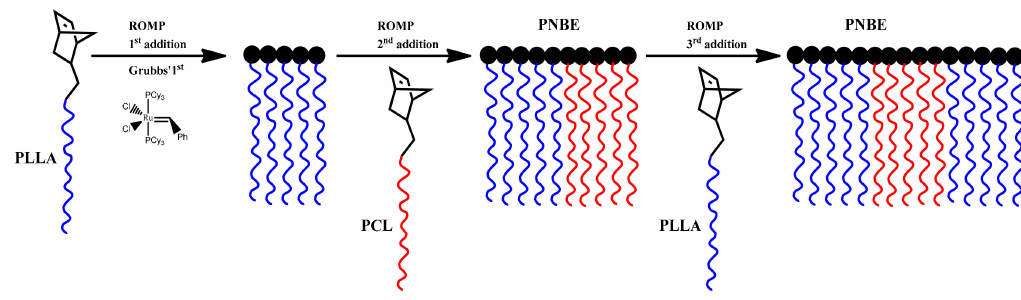
Figure 13. Synthesis of